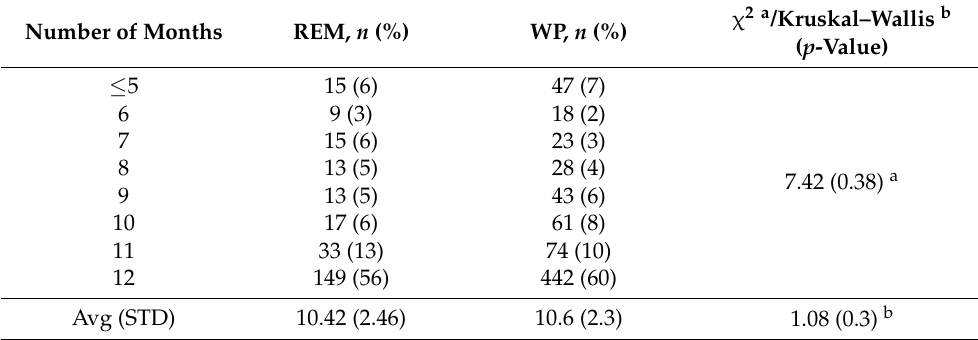
Table 2. Frequency of measurements by month (F.m) presented for White persons (WP) and people from racial and ethnic minority groups (REM); a, chi-square test; b, Kruskal–Wallis test rank. n is the number of users; Avg is the weighted average of the months weighted by the number of